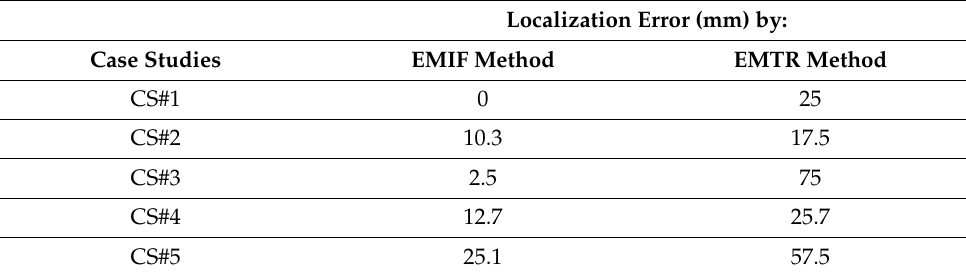
Table 2. Localization errors by the EMIF and the EMTR methods in all 2D simulation case studies. Localization Error (mm) by: